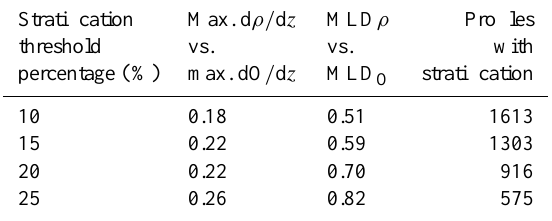
Table 4. Pycnocline and oxycline correlation statistics (all correla- tions have p values (cid:28) 0.01).